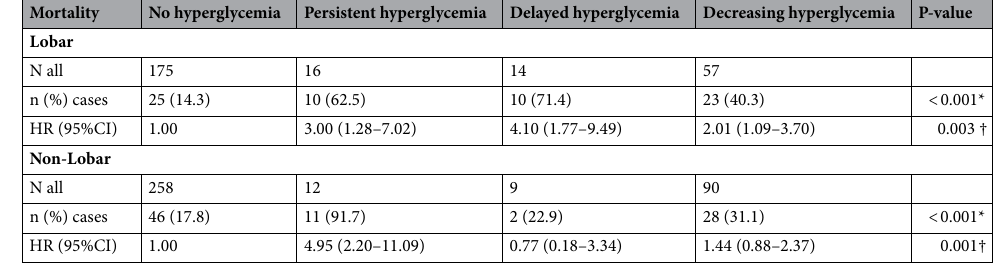
Table 2. Association of glycemic change categories with 30-day mortality according to hematoma location. *P-value from Chi-square. † P-value for overall association from a Cox model adjusted for age, sex, prestroke disability, heart disease, anticoagulant use, Glasgow Coma Scale, hematoma volume and intraventricular hemorrhage.